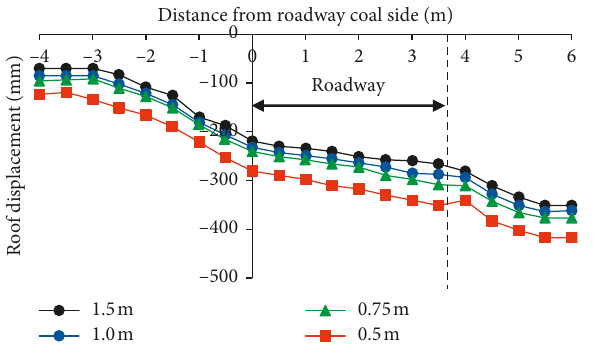
Figure 16: Displacement curve of the roof. Figure